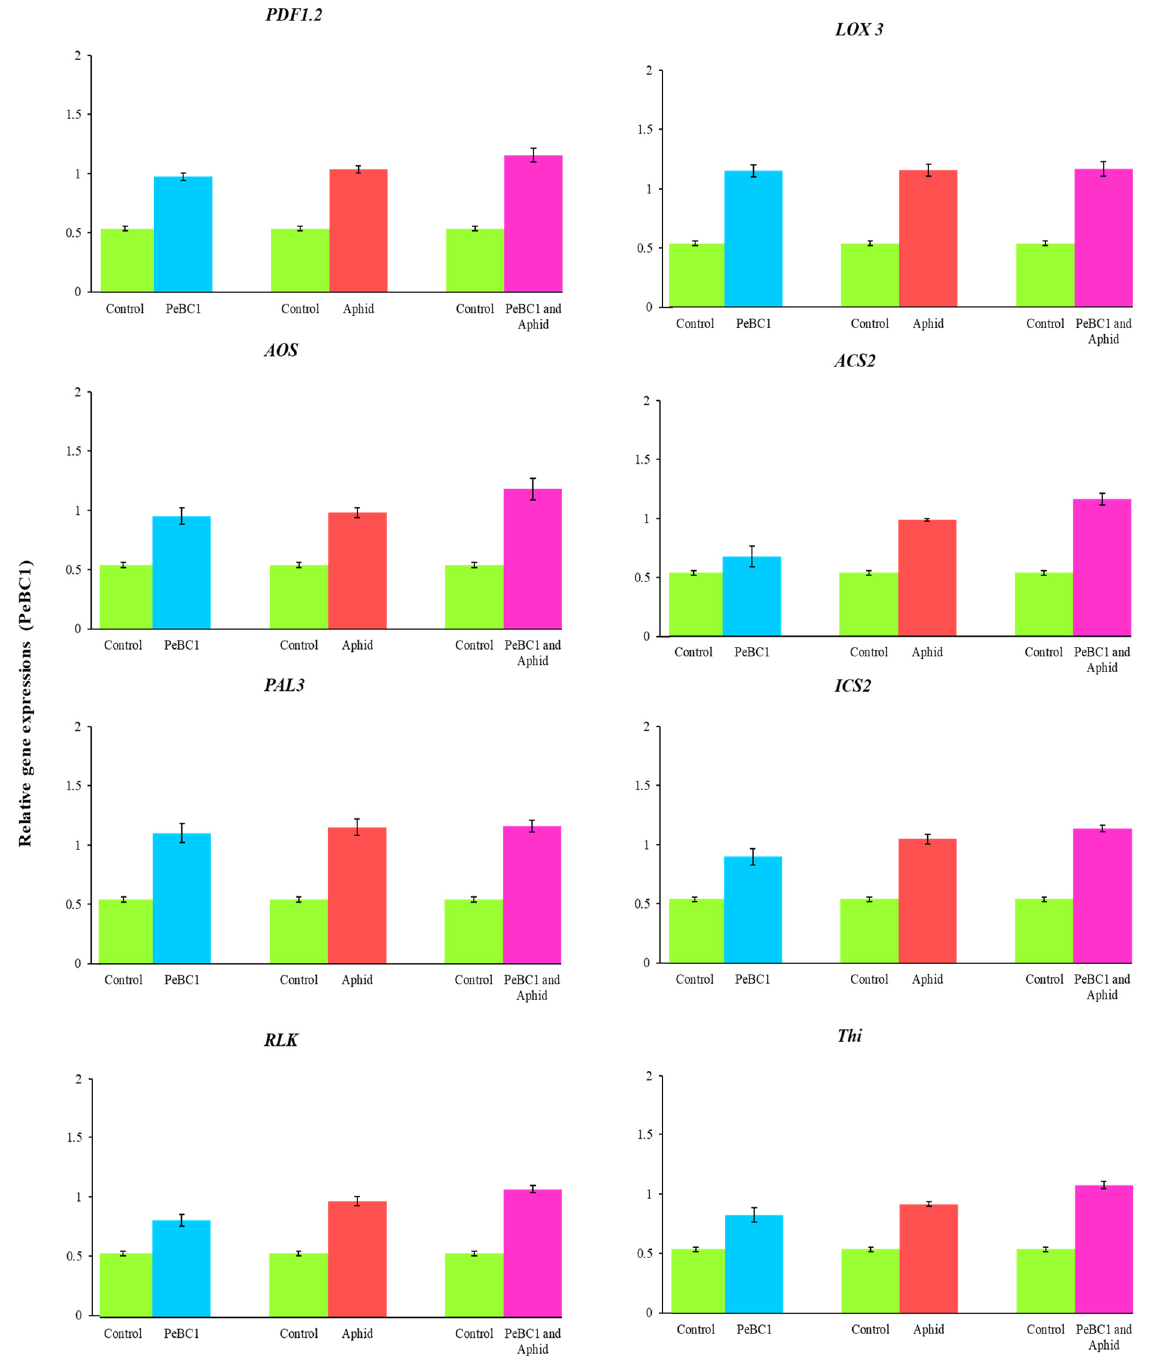
Figure 10. Treatment with PeBC1-elicitor, PeBC1 with aphid, and aphid infestation alone revealed relative expression of the JA, SA, and ET pathway genes. One day after spraying, PeaT1 treatment was carried out. The aphids were inoculated one day after the seedlings were sprayed in both treatments, and the samples were collected one day later. Using SPSS 18.0, data were compared using LSD, one-way ANOVA, and Levene’s test. The fold expression of treated chilli seedlings is represented by bars. Controls were given a relative fold expression of 0.54.